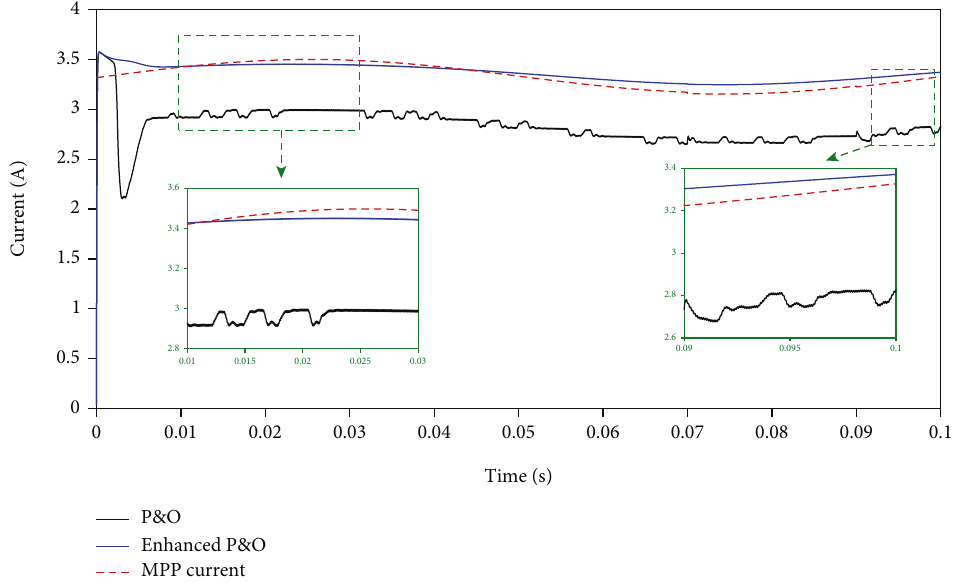
Figure 21: Tracking of current with P&O and enhanced P&O MPPT method under Test 3.